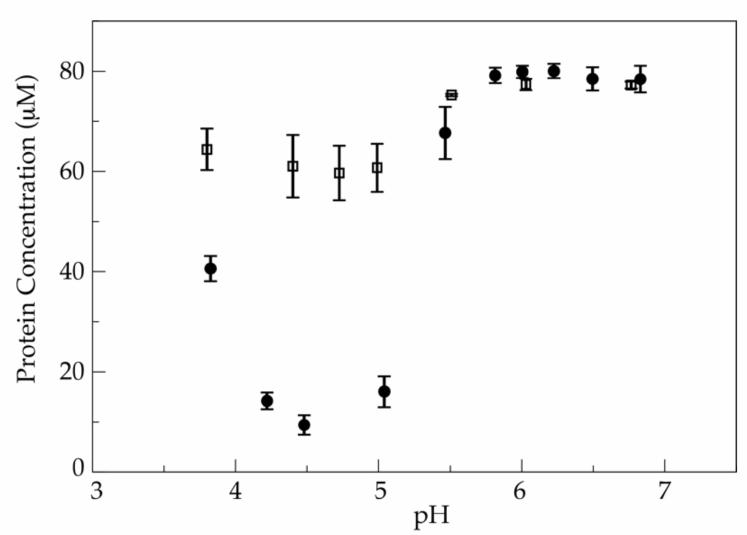
Figure 3. Solubility of the chimera increases by engineering the electrostatic surface of sapC: Aver- age values of the solubility of sapC-PUMA (circles) and sapC-PUMA-DM (squares) measured by absorbance spectroscopy at 280 nm versus pH. Bars indicate the standard error associated to the repetition of the solubility